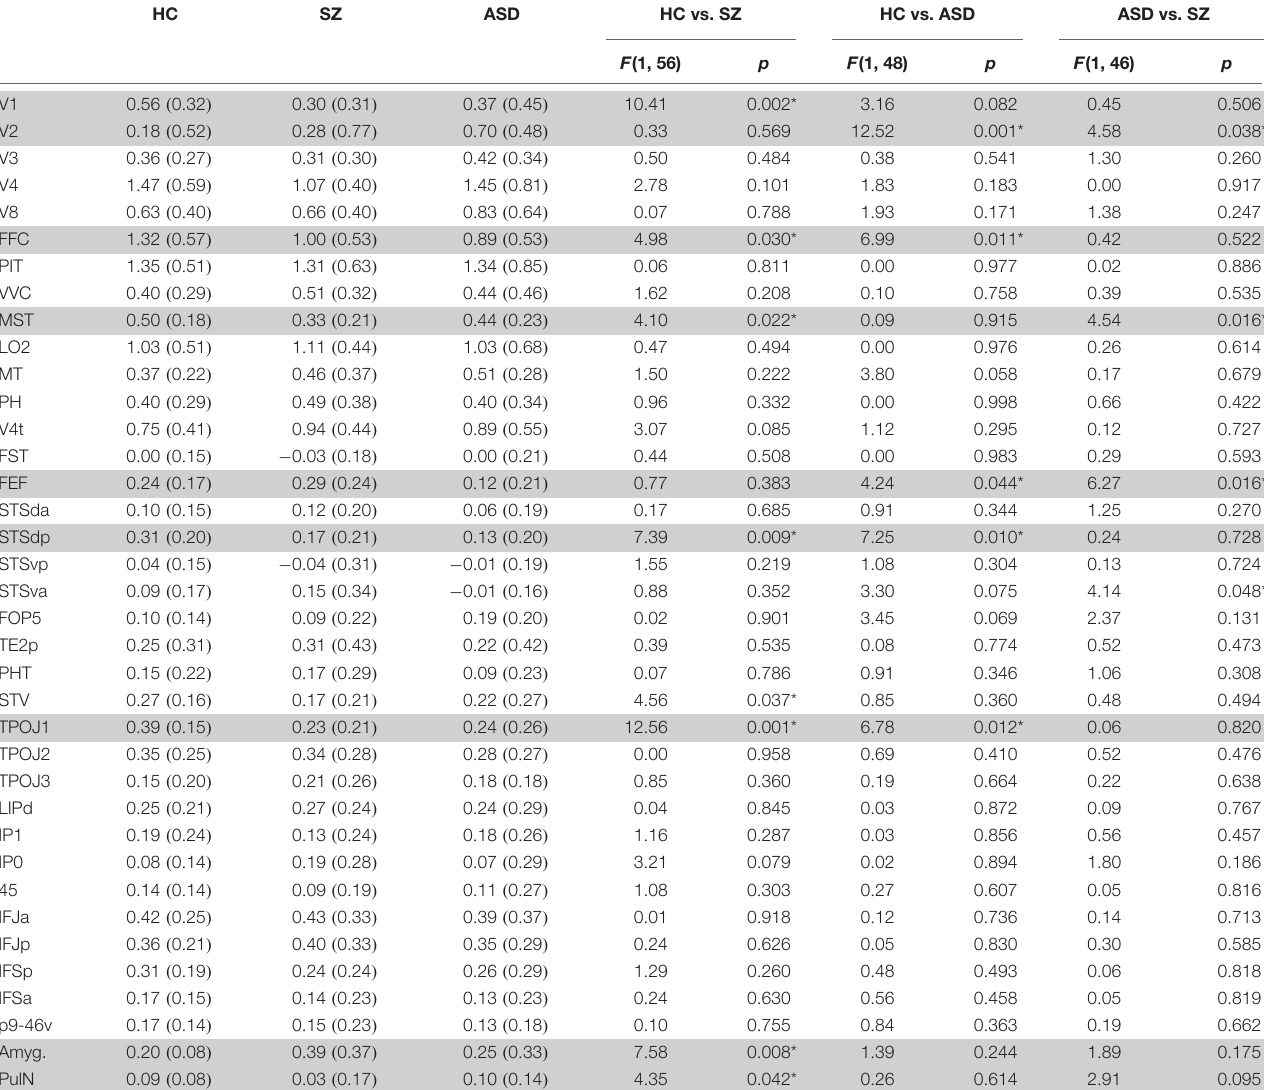
TABLE 2 | Mean beta parameter values in each of the 35 HCP-MMP1.0 (Glasser et al., 2016) parcels shown in Figure 2B for the control (CTL), schizophrenia (SZ), and autism (ASD) groups. HC SZ ASD HC vs. SZ HC vs. ASD ASD vs.